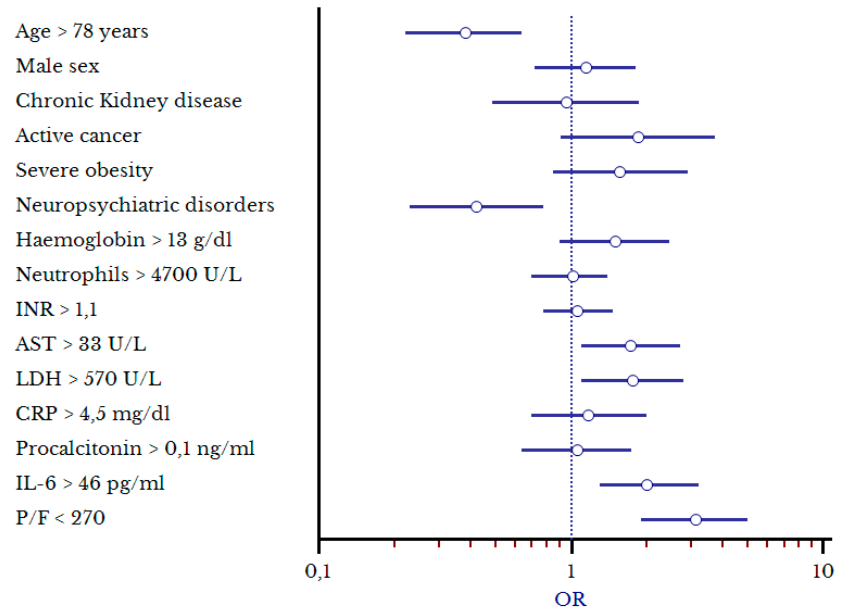
Figure 3. Forest Plot of the factors associated with increased risk of hCPAP delivery.